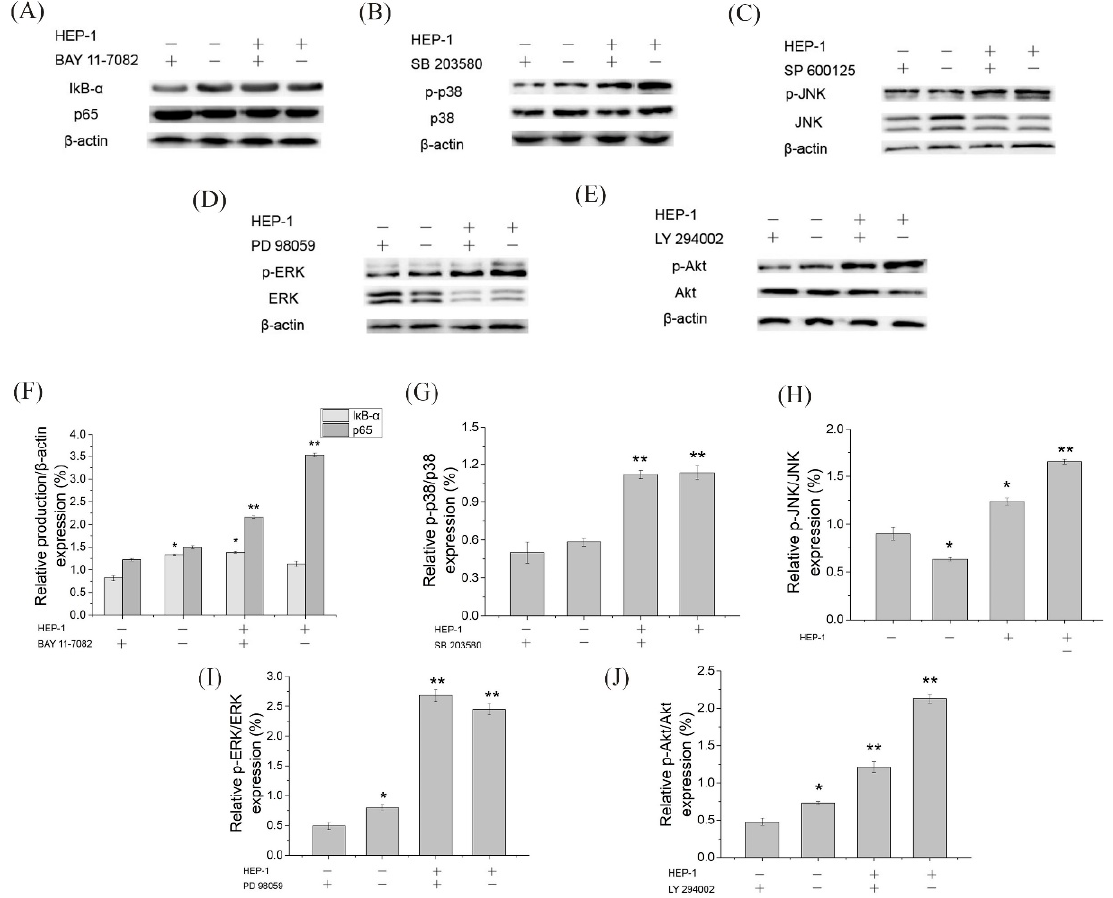
Figure 5. Effects of inhibitors of NF- κ B, MAPK and PI3K/Akt signaling pathways on the HEP-1- induced phosphorylation of related proteins in RAW264.7/Caco-2 cells model. Inhibitory effects of ( A ) BAY11-7082, ( B ) SB203580, ( C ) SP600126, ( D ) PD98095 and ( E ) LY294002 on the NF- κ B, MAPK and PI3K/Akt signaling pathways, and the quantified expression of ( F ) I к B- α or p65/ β -action, ( G ) p-P38/P38, ( H ) p-JNK/JNK, ( I ) p-ERK/ERK and ( J ) p-Akt/Akt. Data are presented as mean ± SD ( n = 3). * p < 0.05, ** p < 0.01 compared with the CK group.